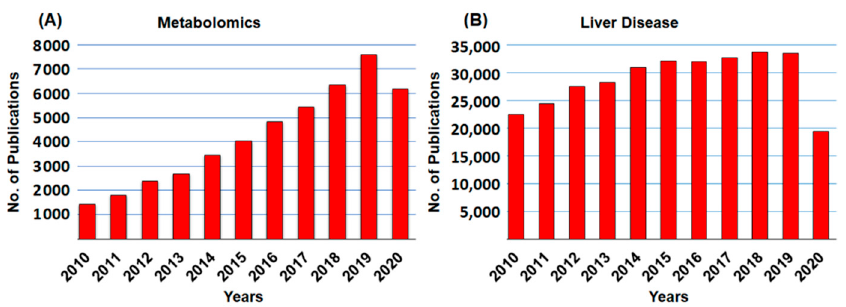
Figure 2. Historical development of publications in ( A ) metabolomics, and ( B ) liver diseases. Total sum of scientific publications between 2010 and 2020. The publications of metabolomics and liver diseases grew every year. All the data were accessed on PubMed on 21 September 2020.